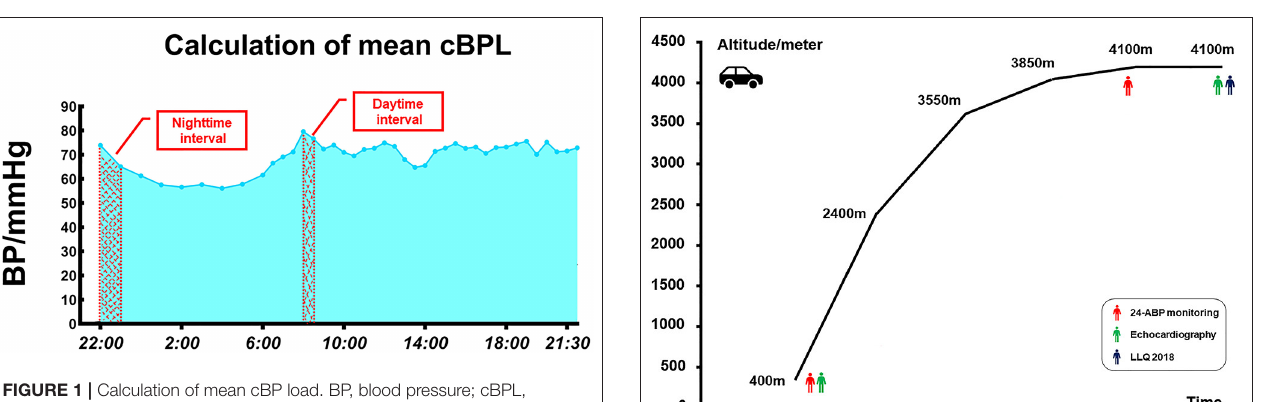
26 (IBM, Armonk, NY, USA). Statistical power